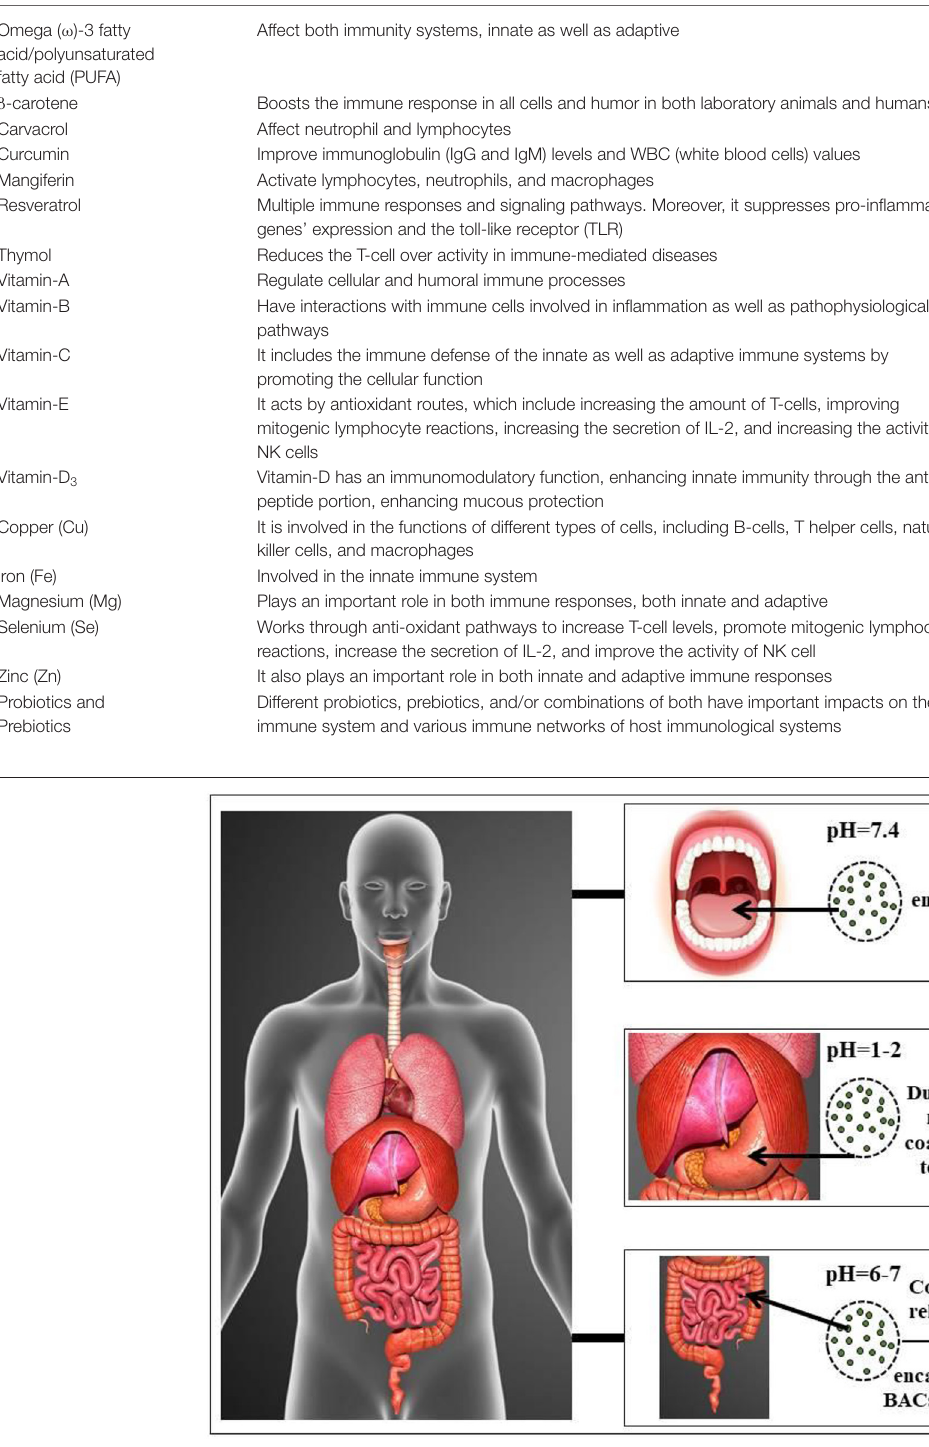
Frontiers in Nutrition |